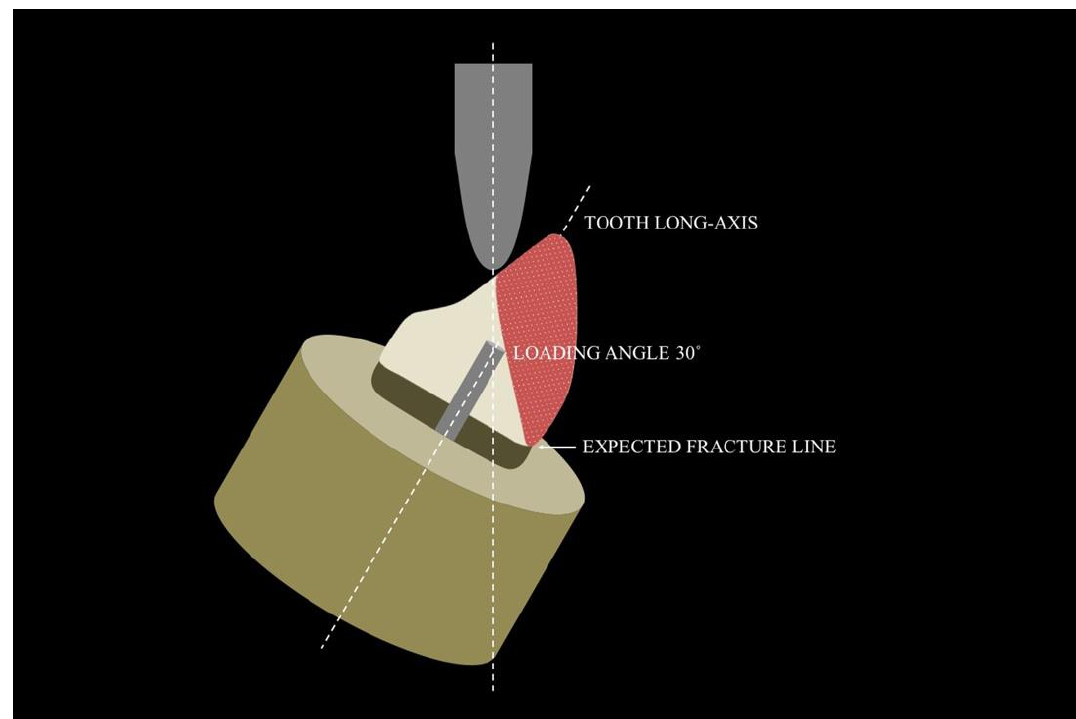
Figure 3. Expected fracture lines according to the loading angles with 30 degrees from the long-axis of the root.